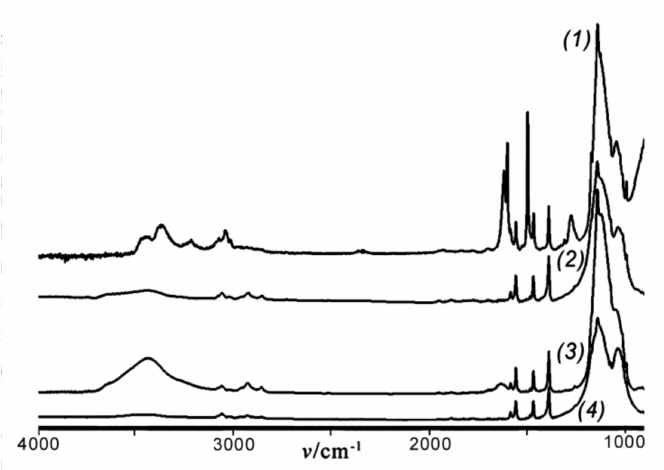
Figure 3. Infrared (IR) spectra of polymer 7 ( 1 ), polymer 8 ( 2 ), polymer 9 ( 3 ), and polymer 10 ( 4 ). As mentioned above, polycondensation of compound 1 under different conditions (at atmospheric pressure or in vacuum with or without MMT) was monitored by APCI MS. Figures 4 and 5 demonstrate the APCI mass spectra of products 3.2 , 3.1 and 5 obtained after heating of compound 1 in quartz and molybdenum glass flasks, and in a molybdenum glass flask in the presence of MMT, respectively, all at atmospheric pressure and 110 ◦ C for comparable periods of time. All three spectra show species formed via condensation between two and four molecules of compound 1 . With that, the spectra demonstrate the loss of (TolSi(O)) 2 O (Tol = m -tolyl) and sometimes of TolSi(O)OH, the former being preliminarily reported for the phenyl analogue [17,24]. This loss most likely occurred in the course of the reactions rather than in the mass spectrometer as fragmentations. Ion peaks corresponding to compounds with the nominal masses 1180 Da for 3.1 and 1162 and 1180 Da for 5 appeared owing to the condensation of two molecules of 1 (single condensation) could also be considered as belonging to the species formed via the decomposition of double condensation products (products of condensation of three molecules of 1 ) according the schemes (M 3 − 5H 2 O) − 2(TolSi(O)) 2 O and (M 3 − 4H 2 O) − 2(TolSi(O)) 2 O. However, the relative abundances of the peak group with the m / z 1180 ion decreased strongly in time ( cf . those in Figure S2a,b in the SM, and Figure 4b). This suggests that the compounds discussed were formed via the condensation of two molecules of 1